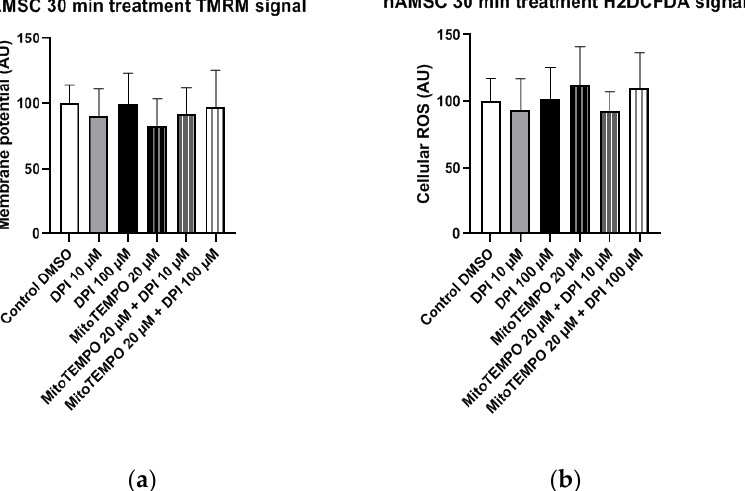
Figure 5. Mitochondrial membrane potential and cellular ROS levels 30 min after the treatment of human amniotic membrane mesenchymal stromal cells (hAMSCs) with diphenyleneiodonium chloride (DPI) and MitoTEMPO. ( a ) Changes in the mitochondrial membrane potential are not present. ( b ) Changes of the cellular ROS levels are not present. Data is represented as means + SD (error bars) ( n = 24; each point was obtained by analyzing 2–4 single cells. p > 0.05; one-way ANOVA followed by multiple comparison post-hoc Fisher’s LSD test. There was no significant differences.